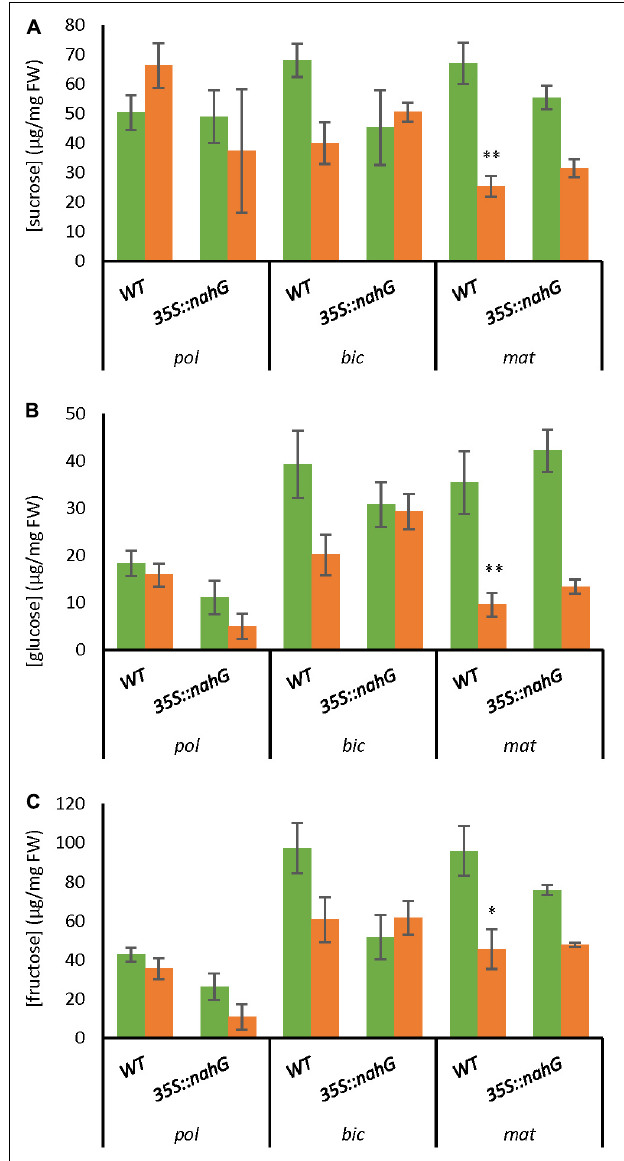
FIGURE 4 | Simple carbohydrate levels in developing anthers of WT and 35S:nahG in CT and LTMH. LTMH consisted of repeated exposure to 34 ◦ C (day) and 28 ◦ C (night). Carbohydrate concentrations were measured after 4, 7, and 10 days of exposure to the treatment, respectively, for polarized microspore (pol), bicellular pollen (bic), and mature pollen (mat) stage anthers. Green bars represent CT, orange bars LTMH. Values indicate the mean ± SD ( n = 6 samples, with pools of 20 (pol), 15 (bic), or 10 (mat) anther cones per sample). (A) Sucrose levels. Two-way ANOVA main effects in pol/bic/mat: temperature P < 0.05/ < 0.01/ < 0.001; genotype ns/ P < 0.05/ns; interaction ns/ P < 0.05/ < 0.01. (B) Glucose levels. Two-way ANOVA main effects in pol/bic/mat: temperature ns/ P < 0.01/ < 0.001; genotype P < 0.01/ns/ P < 0.05; interaction ns/ P < 0.01/ns. (C) Fructose levels. Two-way ANOVA main effects in pol/bic/mat: temperature ns/ns/ P < 0.01; genotype P < 0.01/ P < 0.01/ns; interaction ns/ P < 0.01/ns. ∗ Significantly different within stage between LTMH and CT in WT or between mutant and WT within temperature treatment (brackets), one-way ANOVA with Games–Howell post hoc , P < 0.05; ∗∗ P < 0.01; ∗∗∗ P <